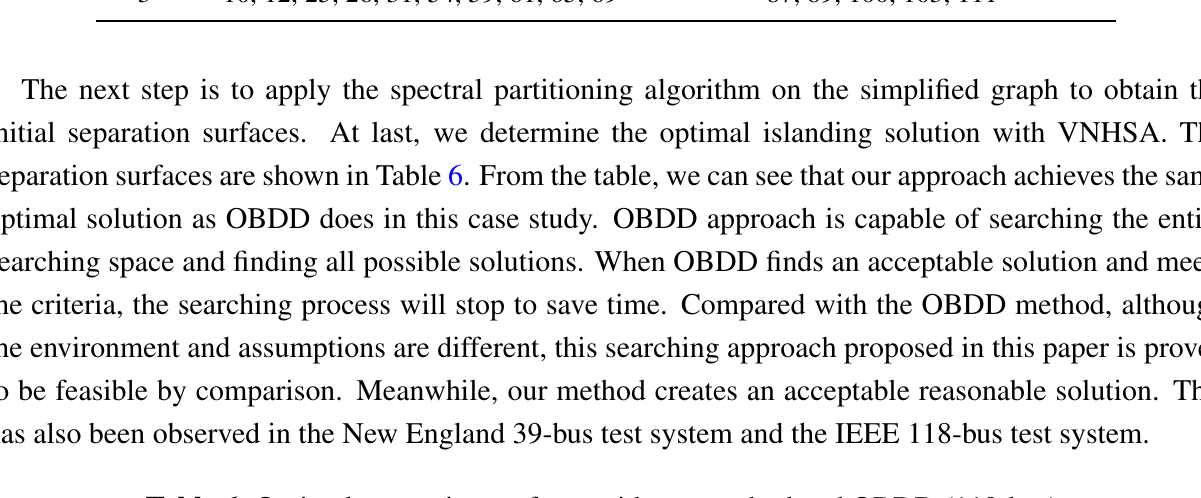
Table 6. Optimal separation surfaces with our method and OBDD